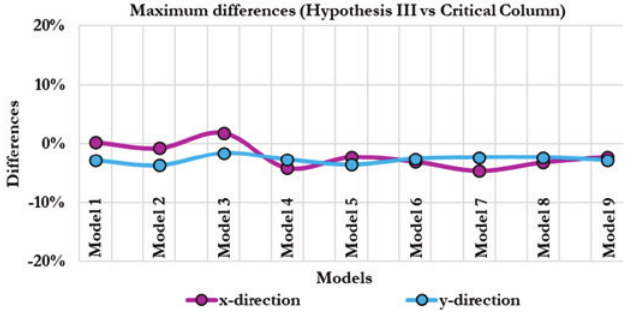
Figure 13 Maximum differences between hypothesis III values and moment amplification for the critical column in each direction of the assessed models